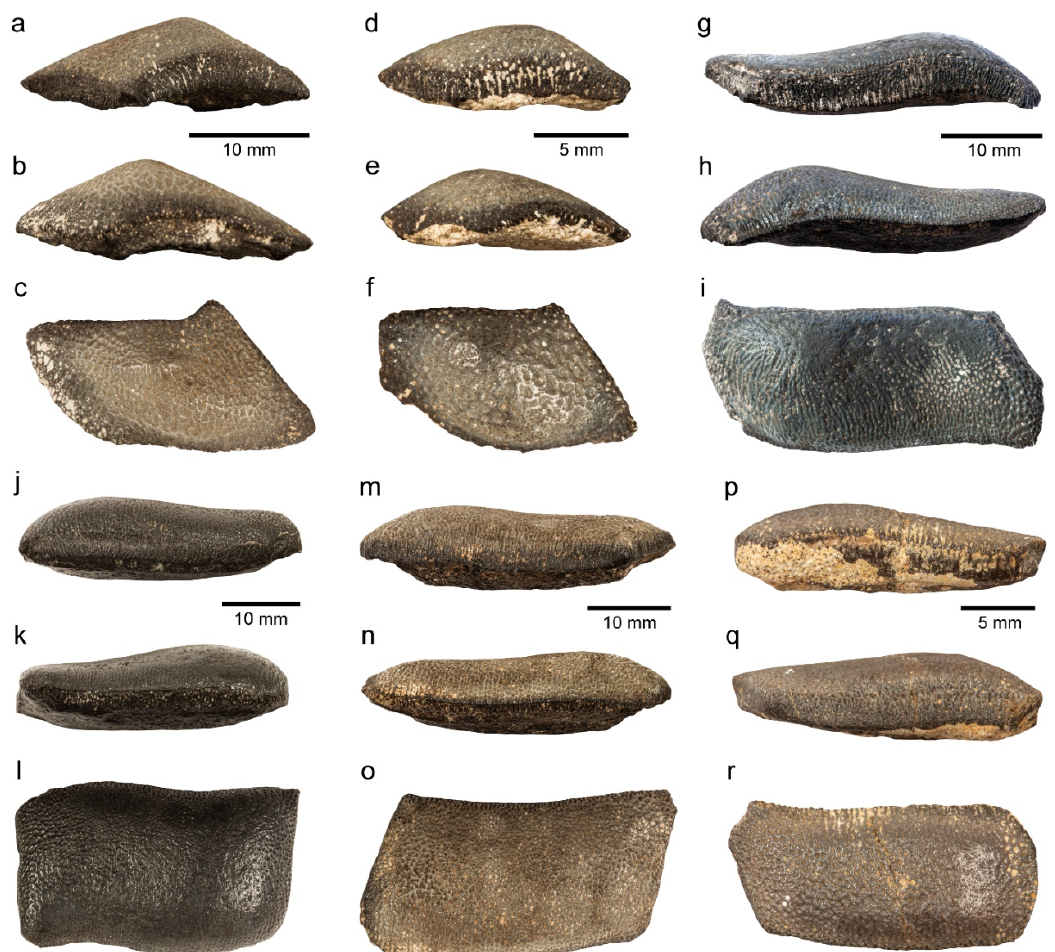
Figure 5. Historically collected hybodontiform teeth from the lower Kimmeridgian of Czarnogłowy, Poland. Strophodus udulfensis (Leuzinger et al., 2017). ( a – i ) First lateral teeth; GG 303/41 in ( a ) labial, ( b ) lingual and ( c ) apical view; GG 303/42 in ( d ) labial, ( e ) lingual and ( f ) apical view; GG 303/43 in ( g ) labial, ( h ) lingual and ( i ) apical aspect. ( j – r ) Second lateral teeth; GG 303/44 in ( j ) labial, ( k ) lingual and ( l ) apical view; GG 303/45 in ( m ) labial, ( n ) lingual and ( o ) apical view; GG 303/46 in ( p ) labial, ( q ) lingual and ( r ) apical